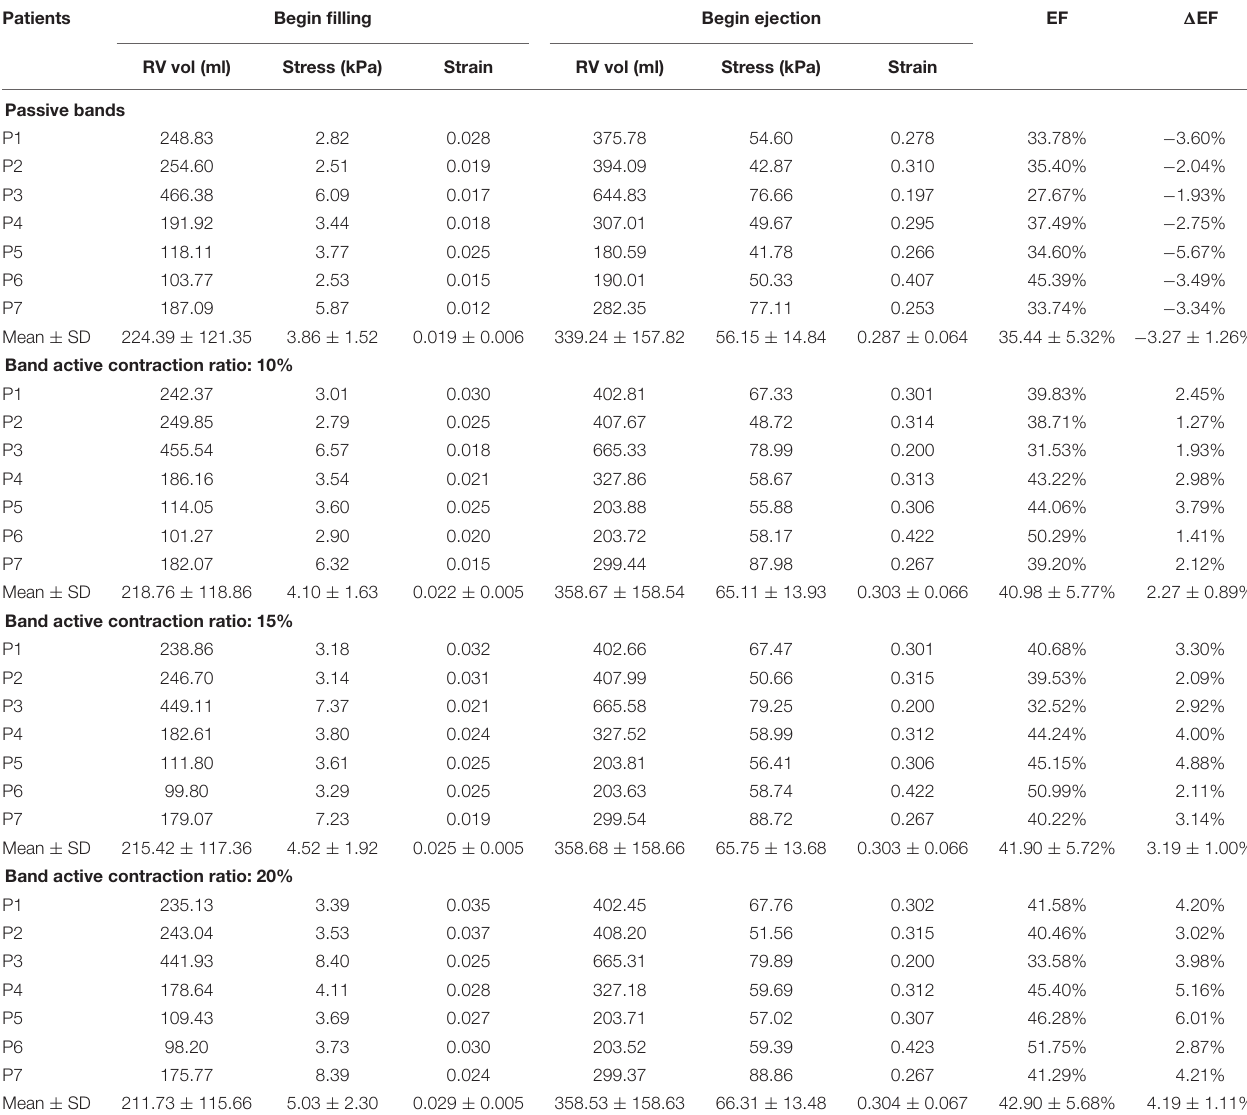
RV, right ventricle; EF, ejection fraction. (cid:49) EF is the difference between the current model EF and EF from baseline no-band model.